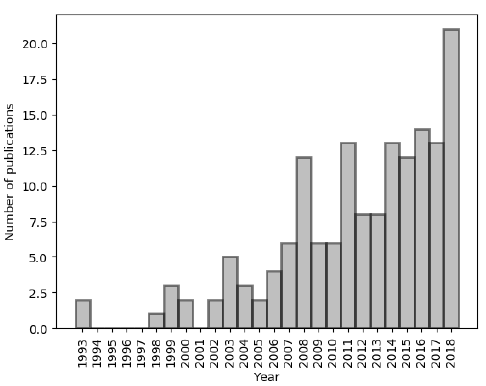
Figure 1. Development of research field regarding Nature Inspired Algorithms (NIA) modifications for tackling Feature Selection